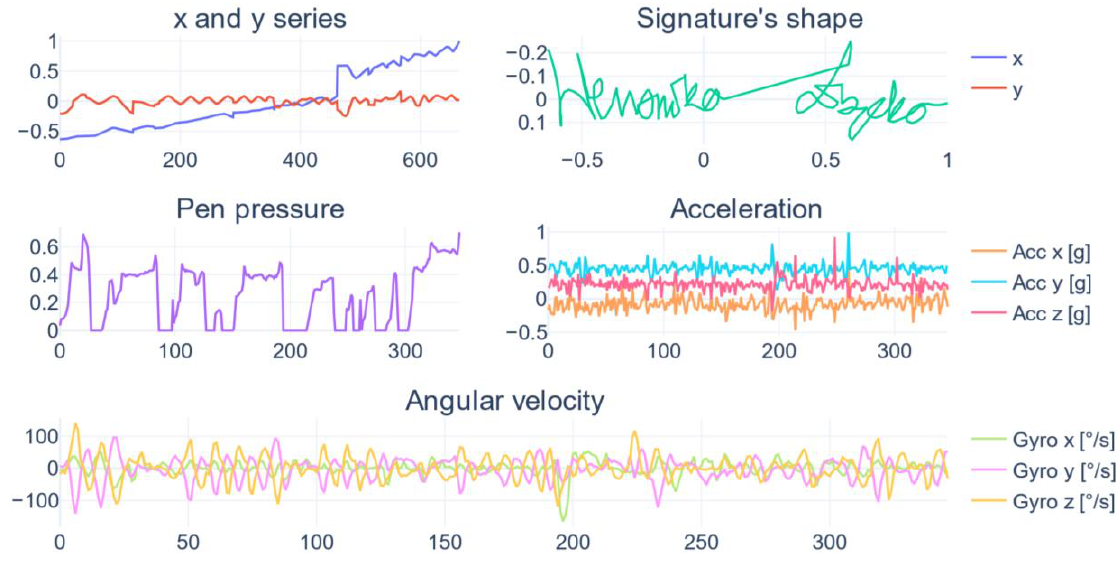
Figure 3. Example of raw signals’ values for subsequent samples for a single signature.